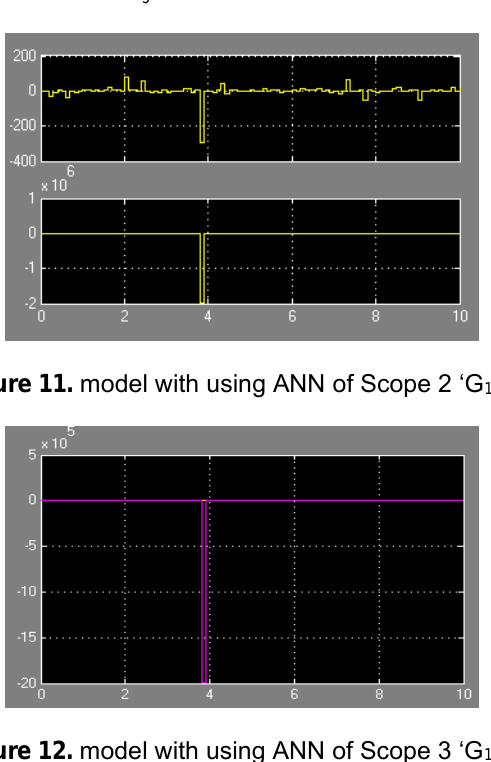
Figure 12. model with using ANN of Scope 3 ‘G 1 (u)’